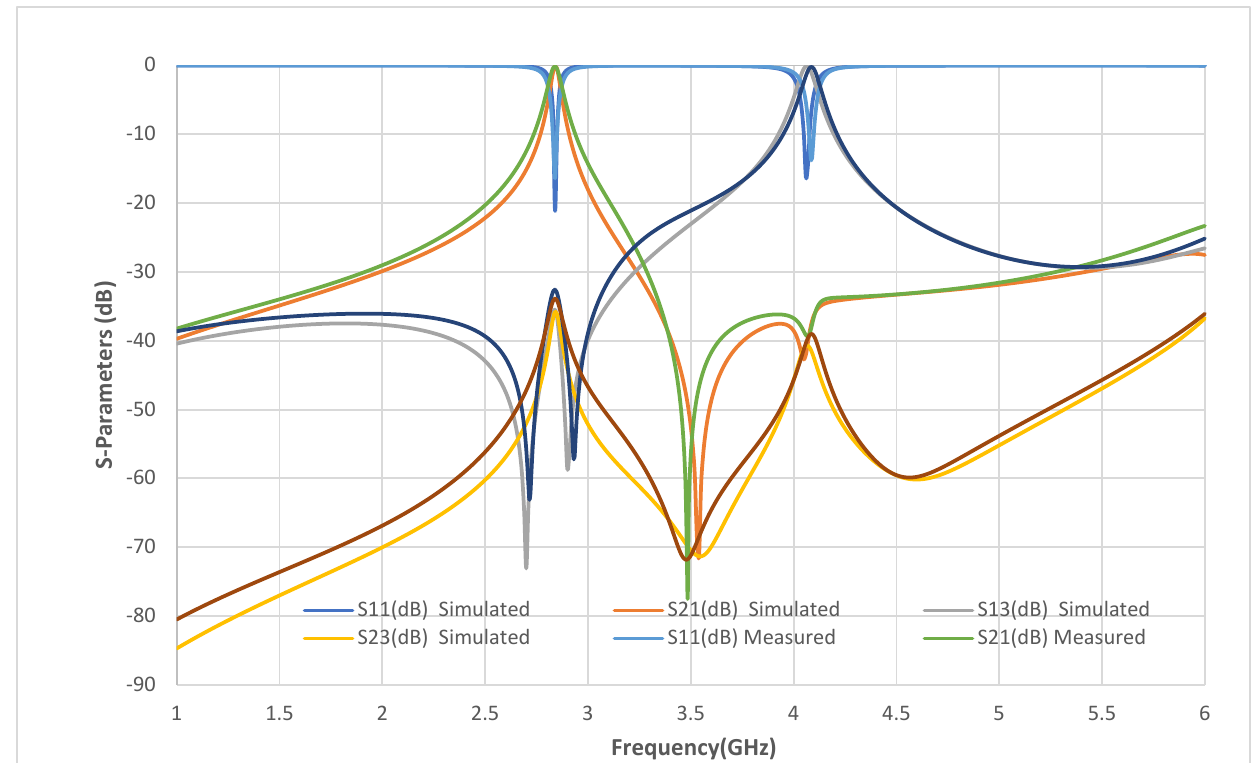
Figure 14. Simulated and measured S parameters.